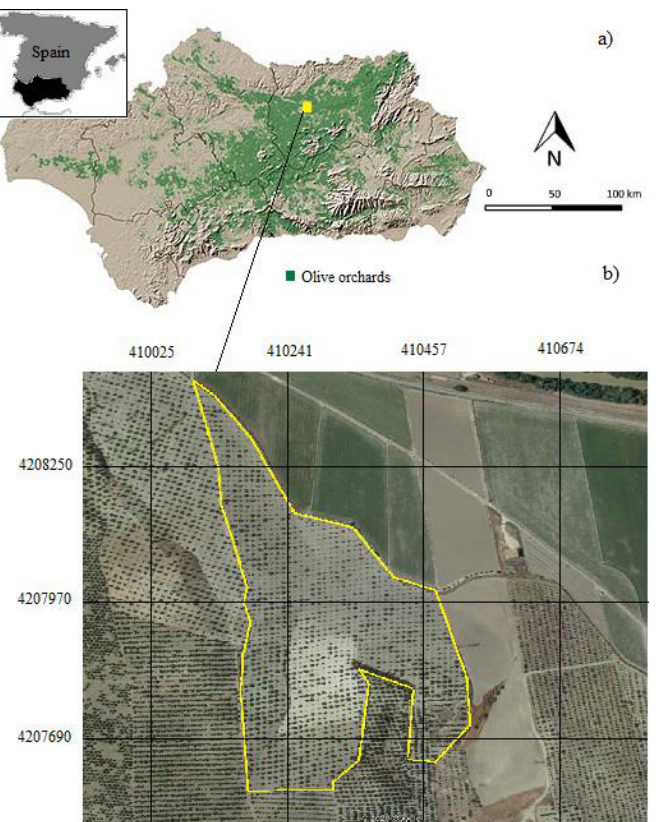
Figure 2. ( a ) Location of study area in Andalusia (Spain). ( b ) Precise location of the farm studied. The coordinates (m) are UTM, zone 30, referred to ETRS89. Source: SIGPAC web, juntadeandalucia.es, (accesed on 15 February 2022). Table 1. Historical yield data of the olive orchard studied. Growing Seasons Yield